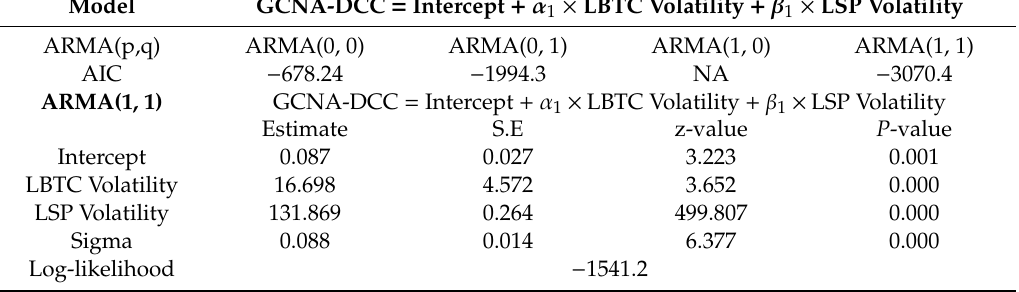
Table 13. Gaussian Copula Marginal Regression with nonlinear asymmetric GARCH (1, 1) volatilities. Selection of p and q for ARMA based on AIC of 4 cases of (0, 0), (0, 1), (1, 0), and (1, 1). ARMA (1, 0) is selected based on AIC criteria. GCMR Model fit of GCNA-DCC with LBTC Volatility, and LSP Volatility of Error dependence structure ARMA (1,